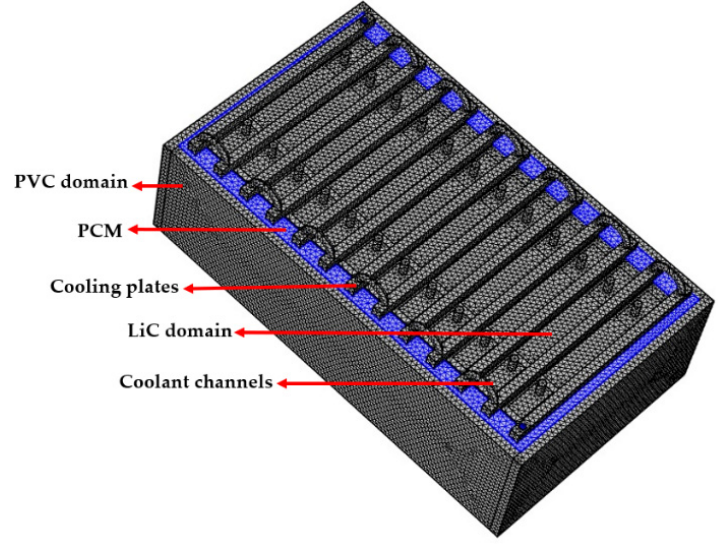
Figure 17. The mesh generation and various domain of the hybrid liquid cooled-PCM TMS for a module of LiC [41].